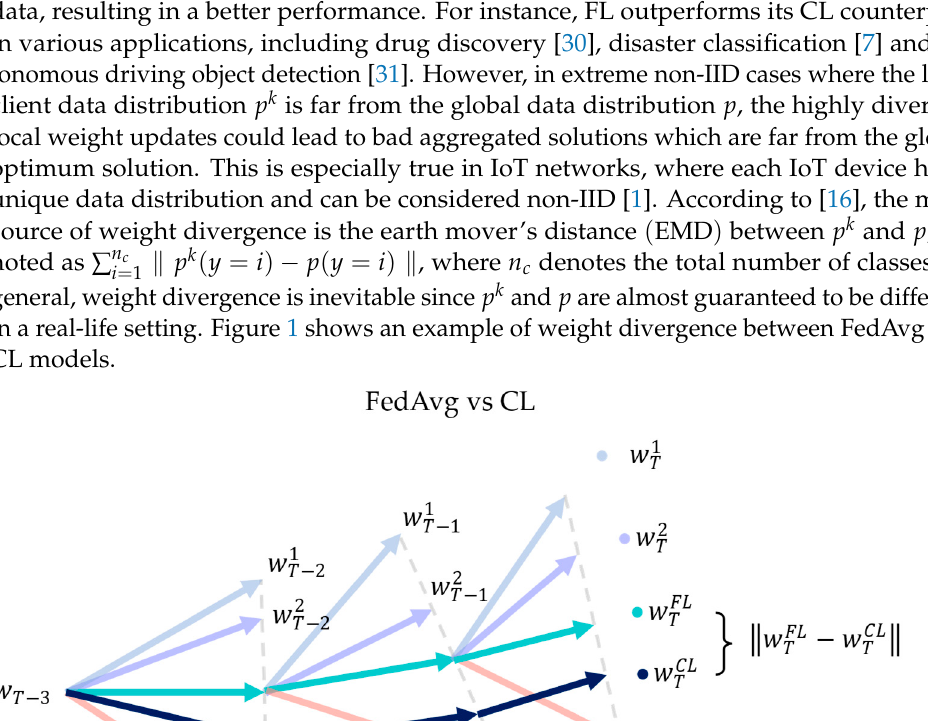
and w CL is inevitable even if both models have the same t t